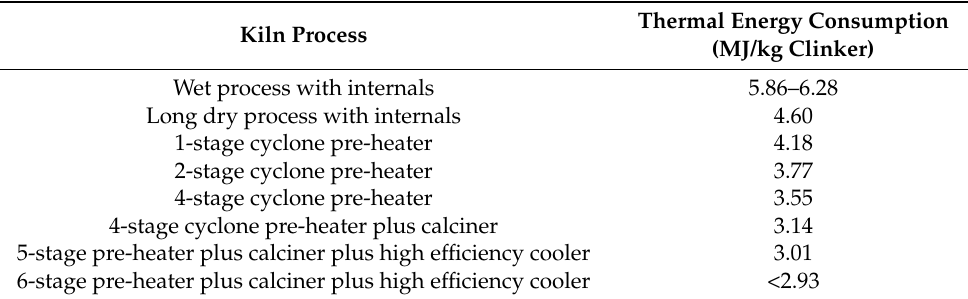
Table 6. Specific thermal energy consumption in different kiln process